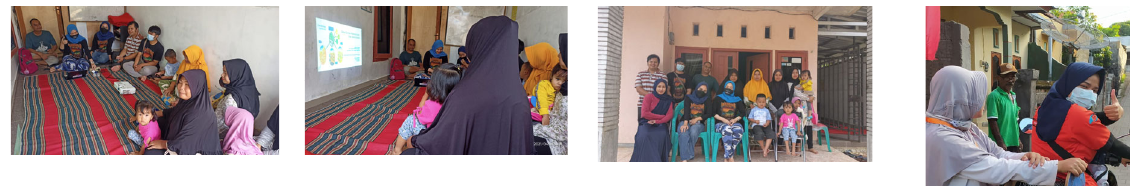
Fig. 8. One of the activities of women empowerment to become internet resellers in Kabandungan